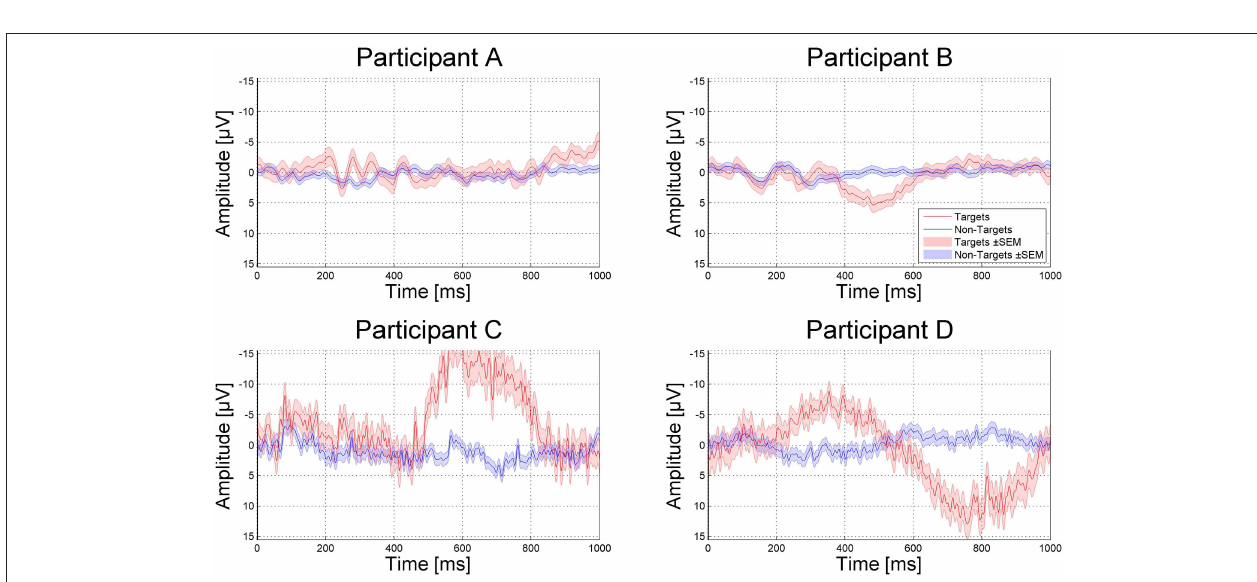
FIGURE 4 | Accuracies reached by motor-impaired end-user participants and according required number of sequences.